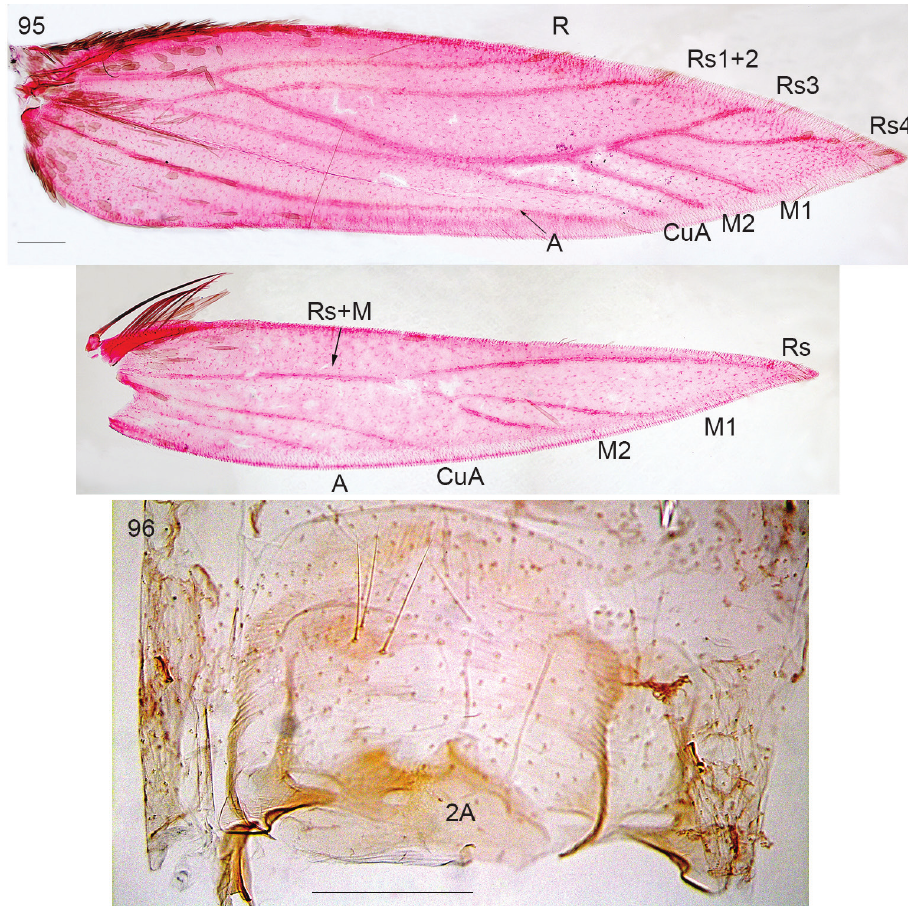
Figure 95–96. Neotrifurcula gielisorum gen. n., sp.n., male. 95 venation, veins labelled, slide EvN4703 96 Abdominal segment 2, showing 2A, slide EvN4703. Scale bars: 200 µm.